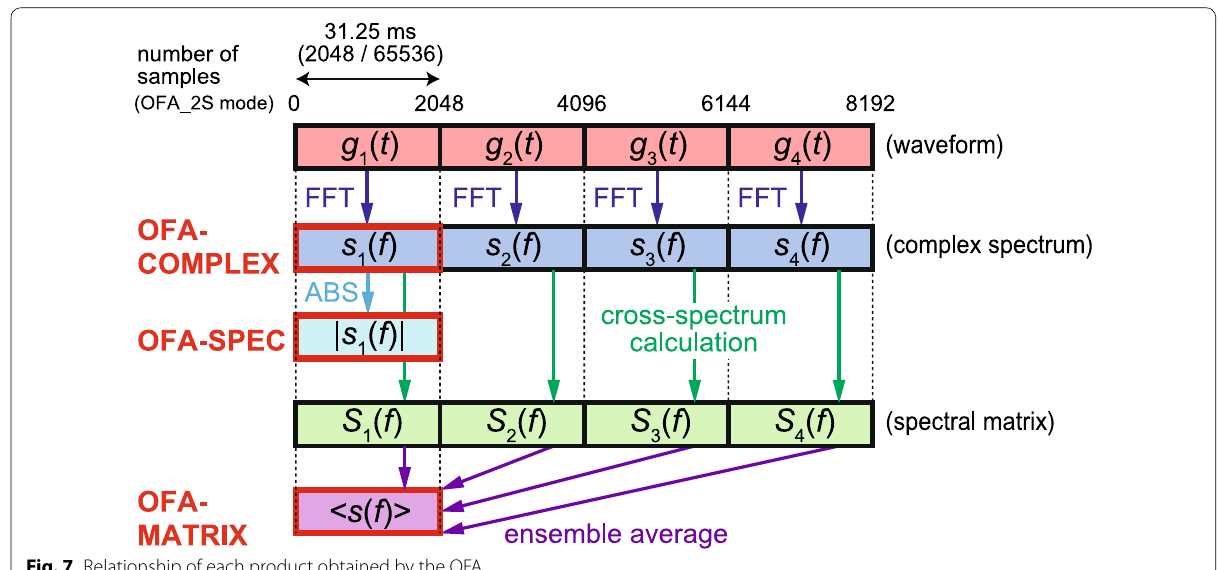
Fig. 7 Relationship of each product obtained by the OFA